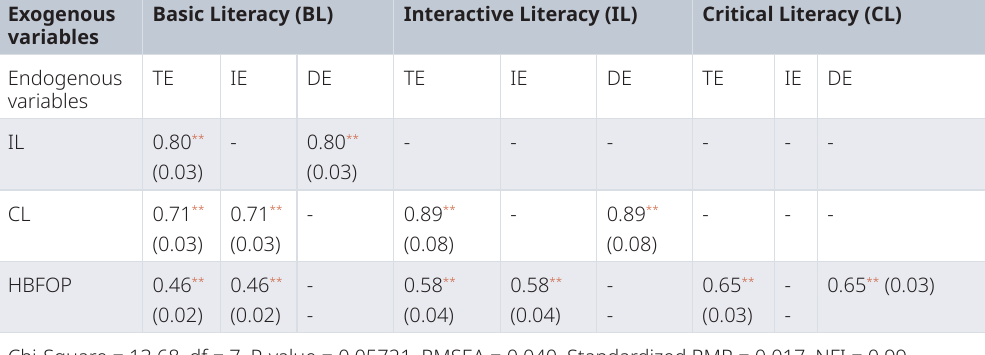
Table 2. Analysis of the influence of variables in the causal model of health literacy for obesity prevention (HLFOP) and health behavior for obesity prevention (HBFOP). Exogenous Basic Literacy variables